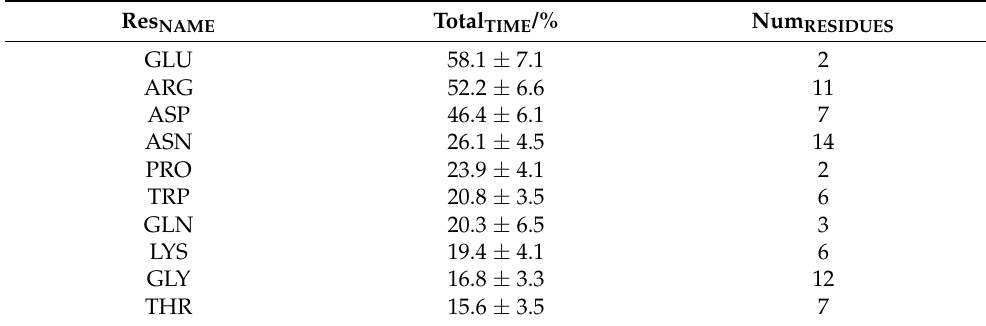
Table 2. List of top 10 amino acid types near which (within 0.3 nm of distance) free arginines stay on average for the longest proportion of simulation time. The column Num RESIDUES denotes the total number of a particular residue type in HEWL.